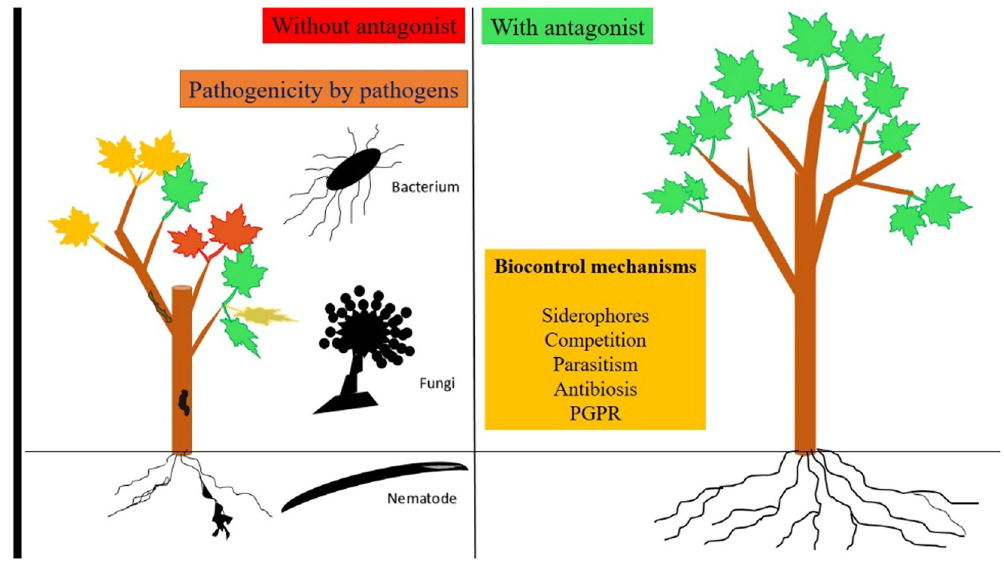
Figure 1: Left: in the absence of antagonists, di ff erent pathogens especially fungi, bacteria, and nematodes can cause losses in plants. Over time, a ff ected plants will show the weakness in the development and symptoms of diseases. Right: in the presence of antagonists with di ff erent biocontrol mechanisms, such as competition, parasitism, and antibiosis, the pathogens will not be able to progress in the host, and thus, the plant can grow and develop well rather than the absence of antagonists in soil and tissues of